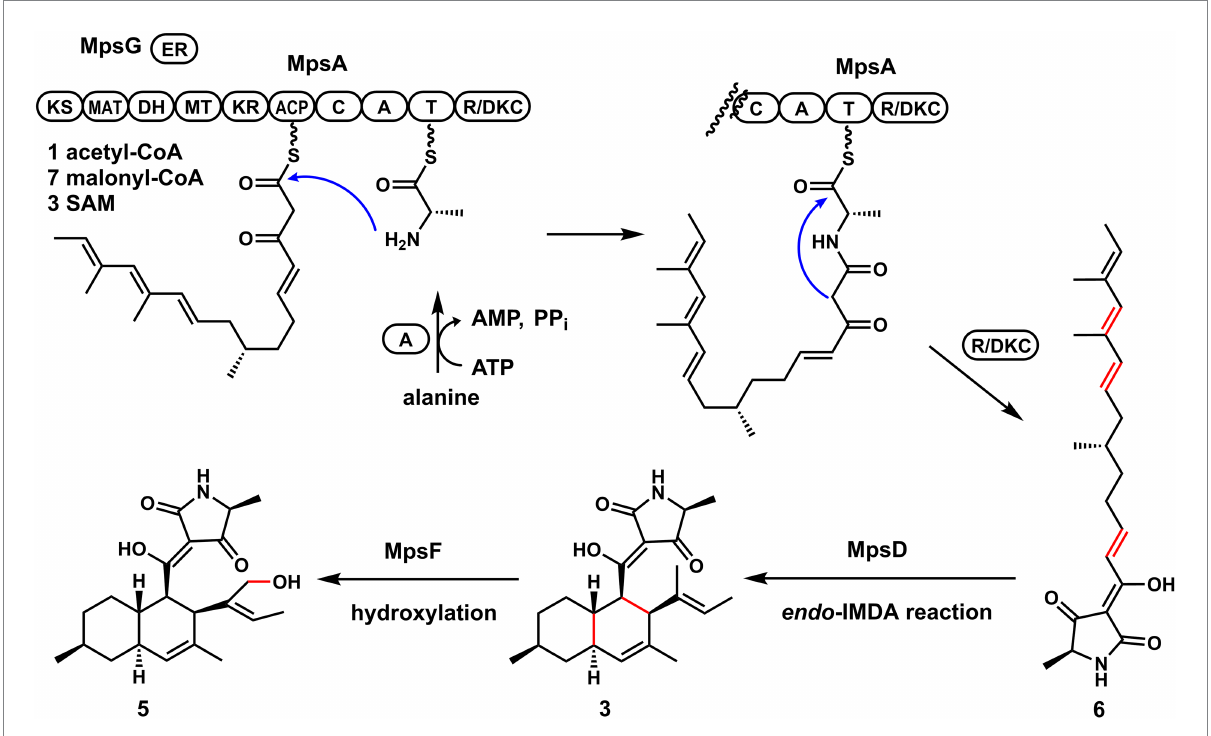
FIGURE 4 The proposed biosynthetic pathway of